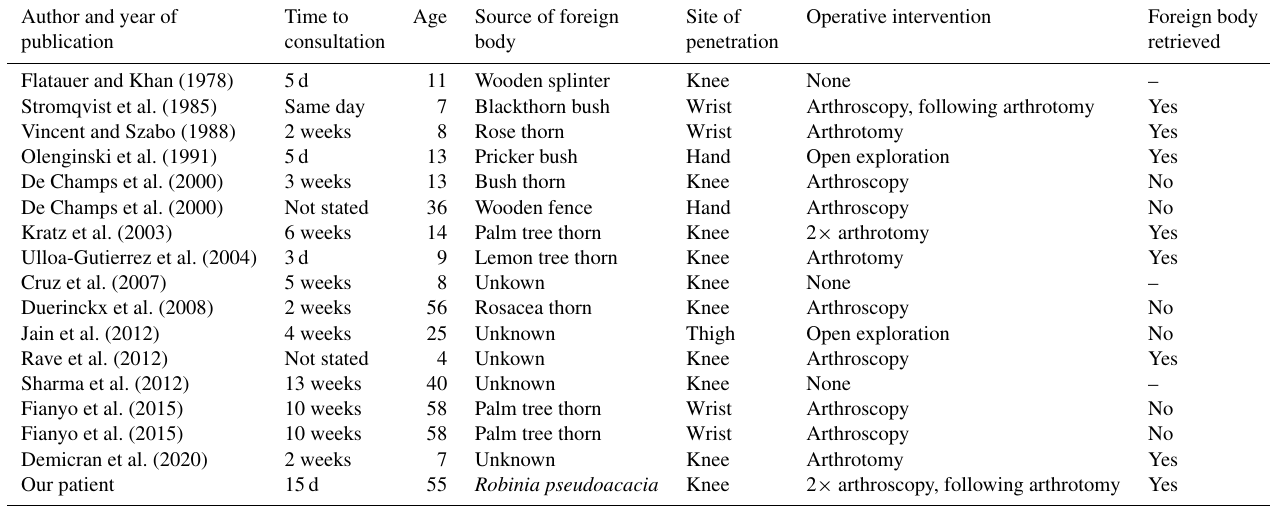
Table 1. Case reports with septic arthritis or synovitis of the joint due to an infection with Pantoea agglomerans